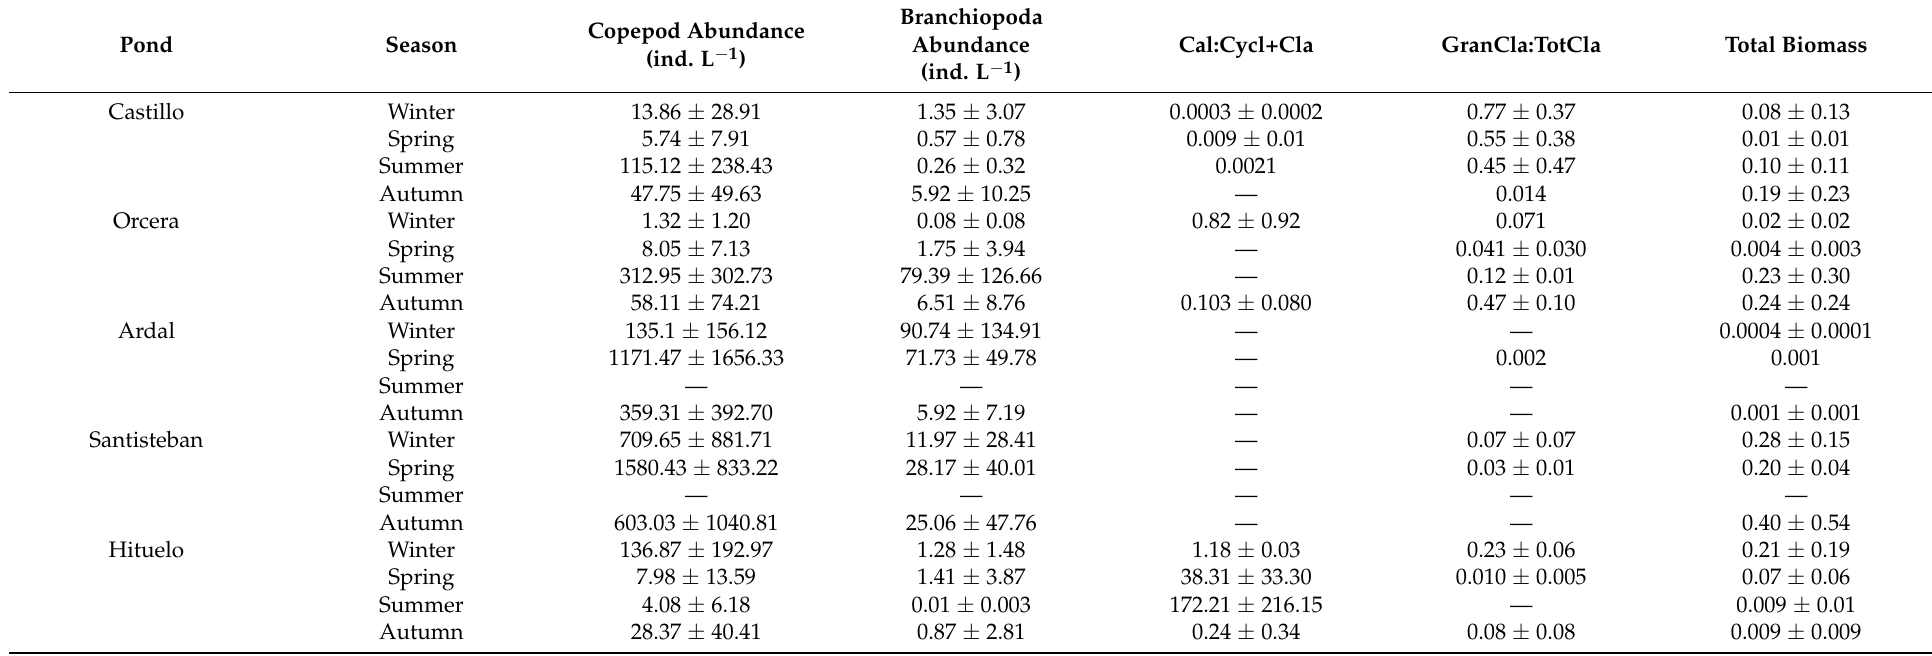
Table 3. Seasonal mean abundance and standard deviation of copepods and branchiopods (ind L − 1 ) in all studied ponds. Additionally, shown Cal:Cycl+Cla, GranCla:TotCla ratios and total mean and standard deviation for biomass values (mg L − 1